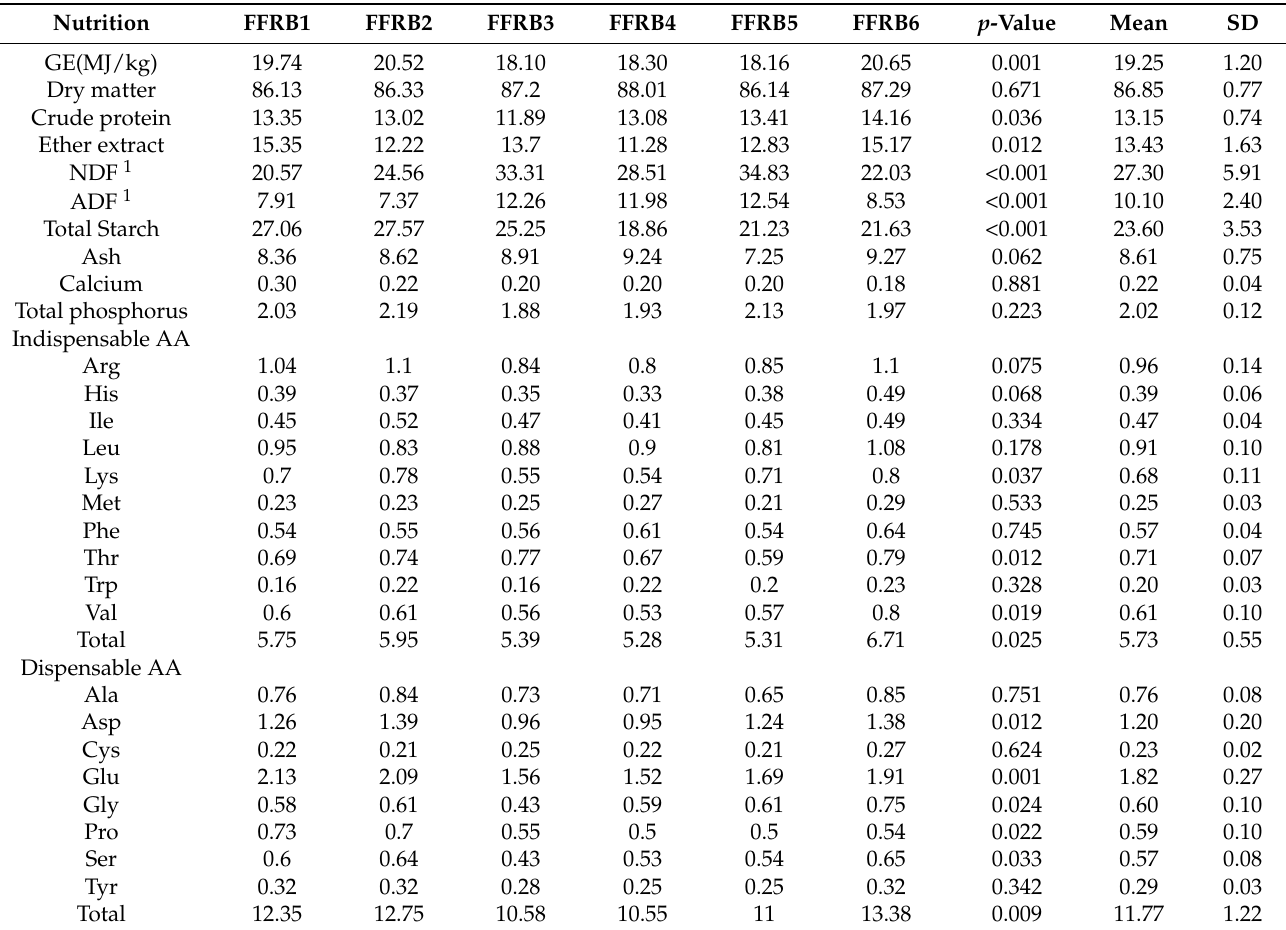
Table 4. Analyzed nutrition and amino acid composition of different sources FFRB (%).